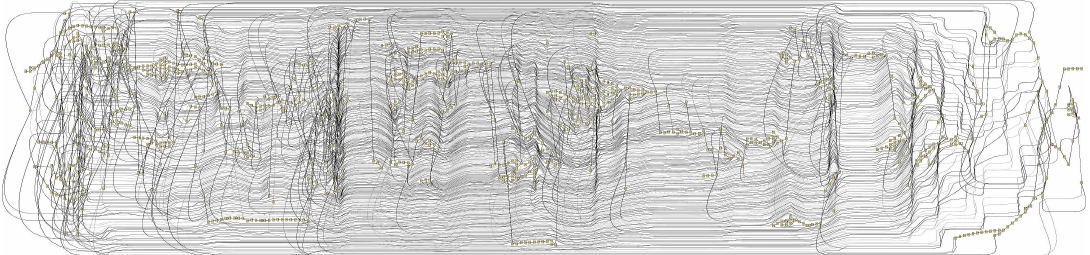
Figure 4. Fuzzy miner model of the BT’s Customer Diagnostic